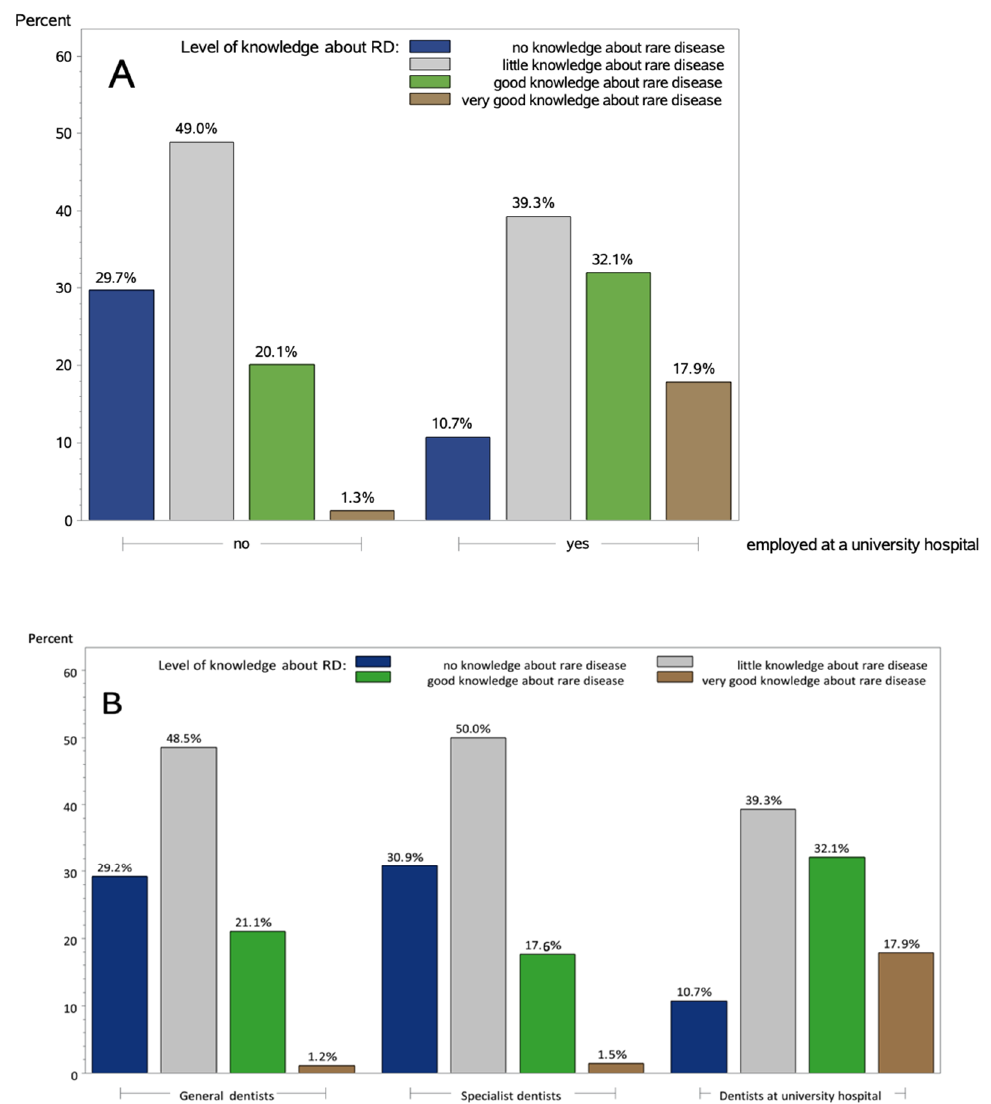
Figure 2. Level of knowledge. ( A ) Comparing dentists employed at vs. outside a university hospital. There were significant differences in the level of knowledge between dentists at a university hospital and dentists in a different current work location (tested via two-sided exact Fisher test, p * < 0.001 adjusted using the Bonferroni method). ( B ) Comparing general dentists, specialist dentists and dentists at a university hospital. There were significant differences in the level of knowledge between general dentists, specialist dentists and dentists at a university hospital (tested via two-sided exact Fisher test, p * = 0.012 adjusted using the Bonferroni method).